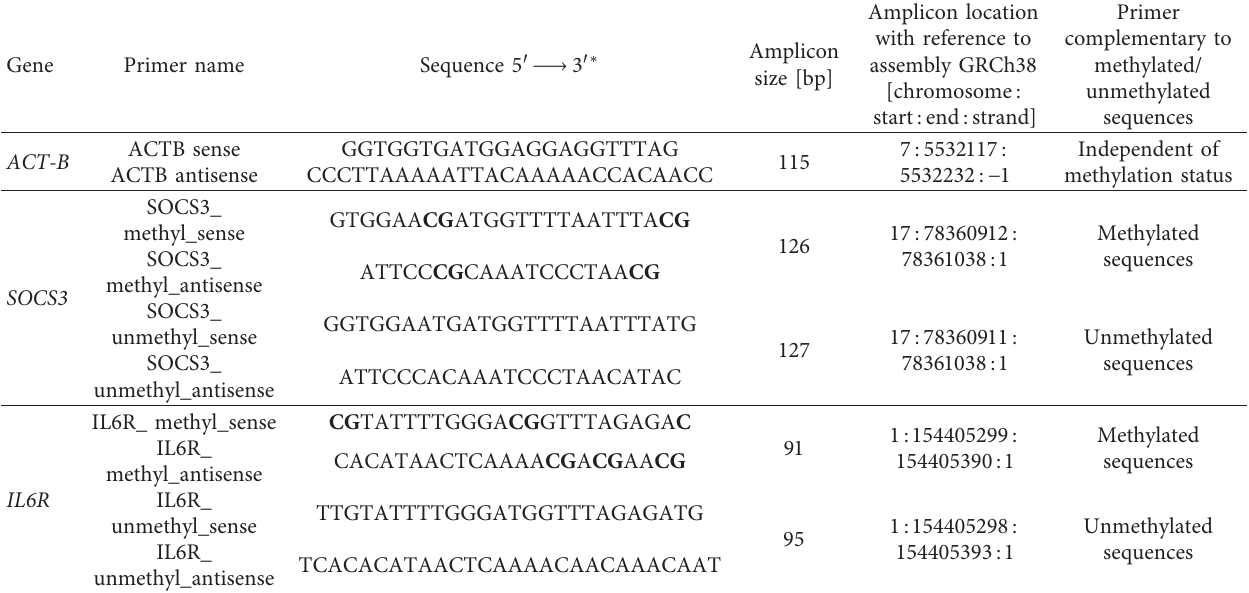
Table 1: Characteristics of primers and